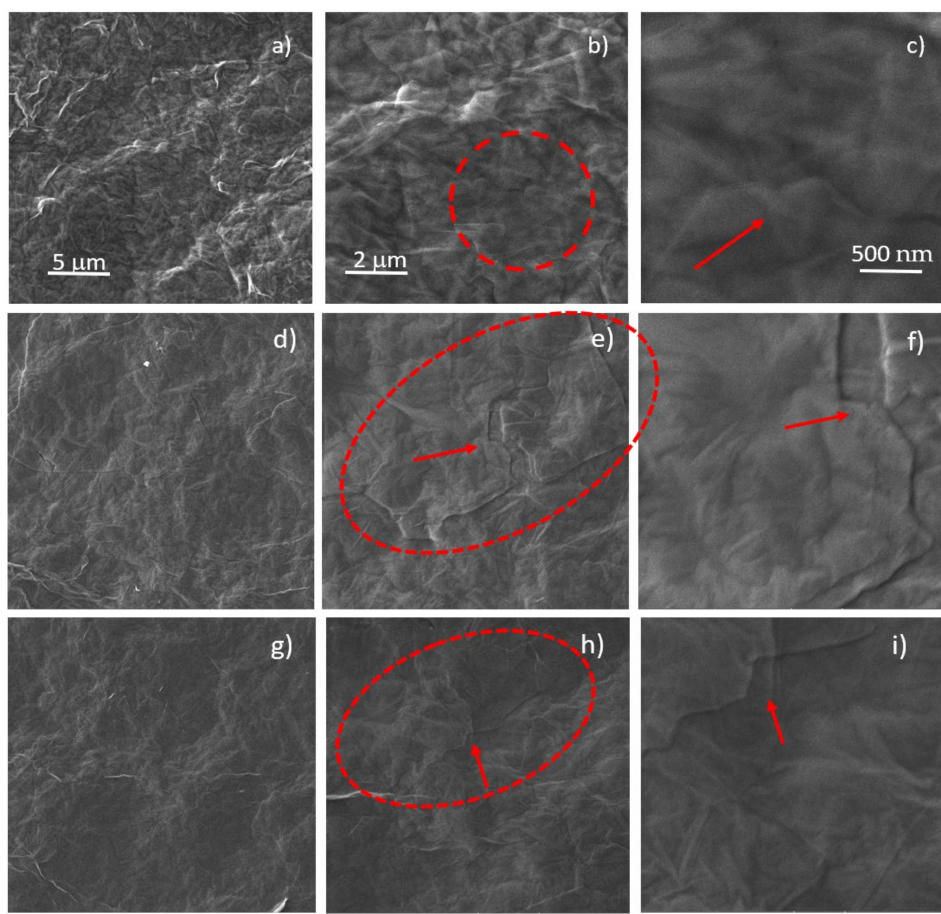
Figure 3. SEM images of GO foils irradiated by the 3 MeV H + ions at the 5 × 10 13 ions/cm 2 ( a – c ), He + ions at 5 × 10 12 ions/cm 2 ( d – f ) and O + ions at 5 × 10 12 ions/cm 2 ( g – i ) fluences (A colour version of this figure can be viewed